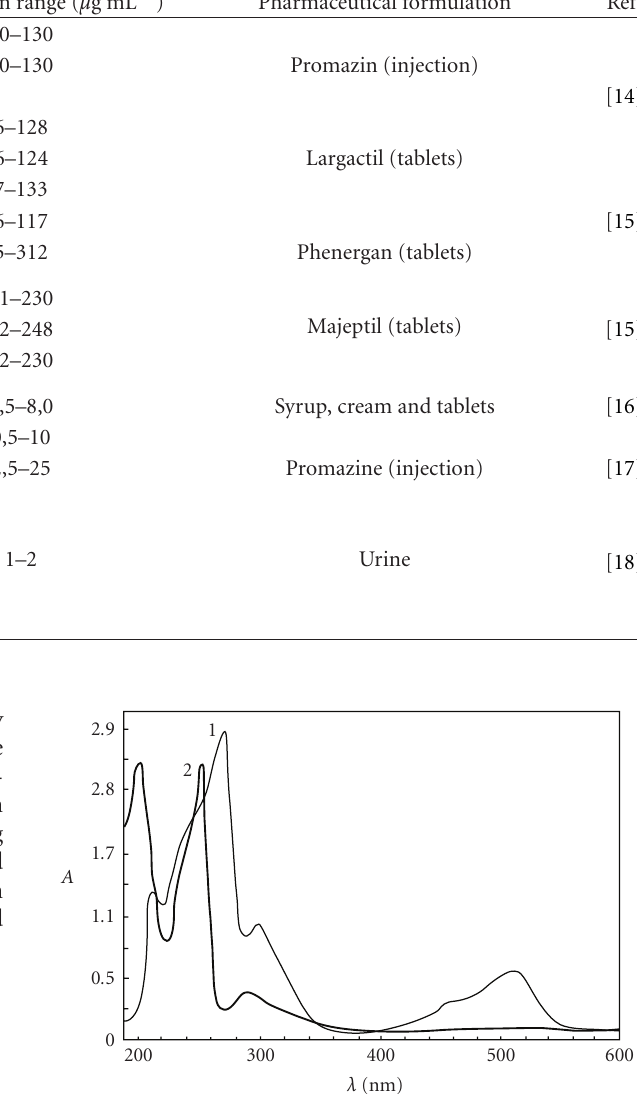
Figure 1: UV-VIS spectra of 1-colored product of reaction PM- Fe(III) (C PM = 3 · 10 − 4 M, C Fe(III) = 3 · 10 − 4 M; 2-nonoxidized form of PM (C PM = 4 · 10 − 4